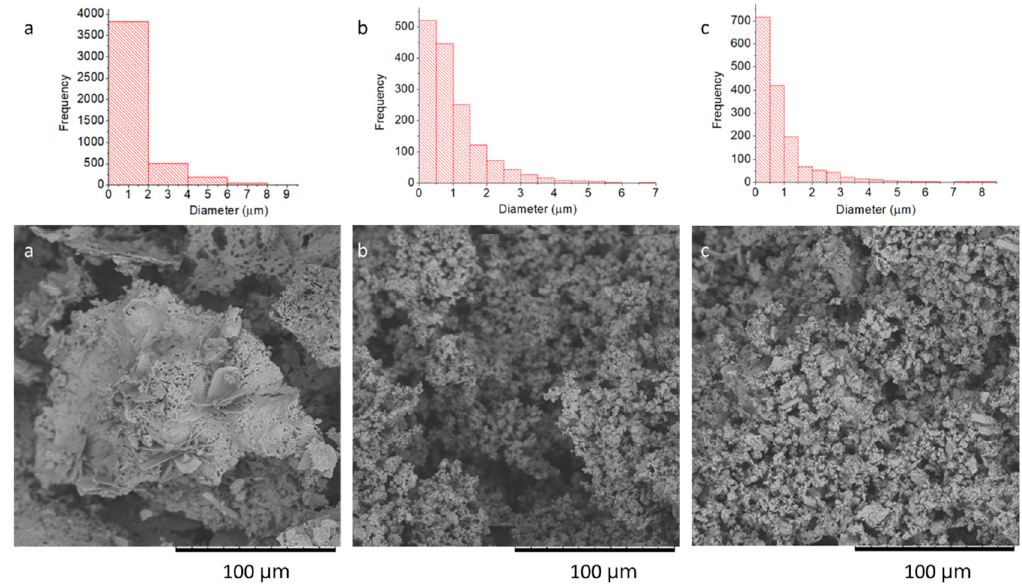
Figure 7. Histograms obtained via image analysis showing the particle size distribution obtained via ( a ) 5:1, ( b ) 1:1, and ( c ) 1:5 molar ratios of tetramethyl ammonium nitrate / YBaCu nitrates. ( a – c ) SEM images of their respective synthetic conditions. The reactions were carried out at a maximum temperature of 920 °C.